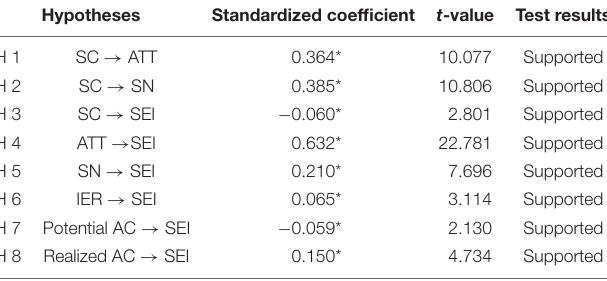
TABLE 3 | Results of path analysis and hypothesis